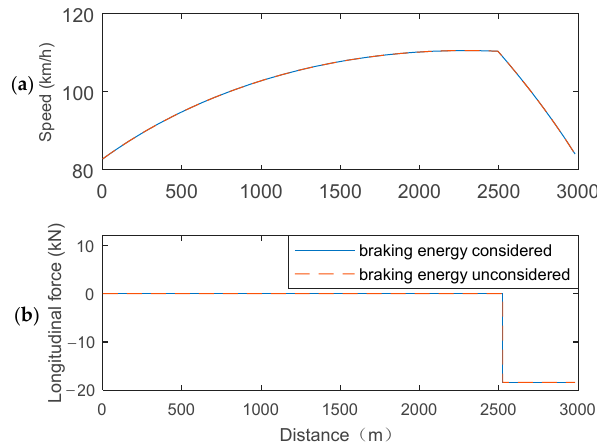
Figure 8. Concave road profile and its road slope. ( a ) Road slope profile; ( b ) road profile.